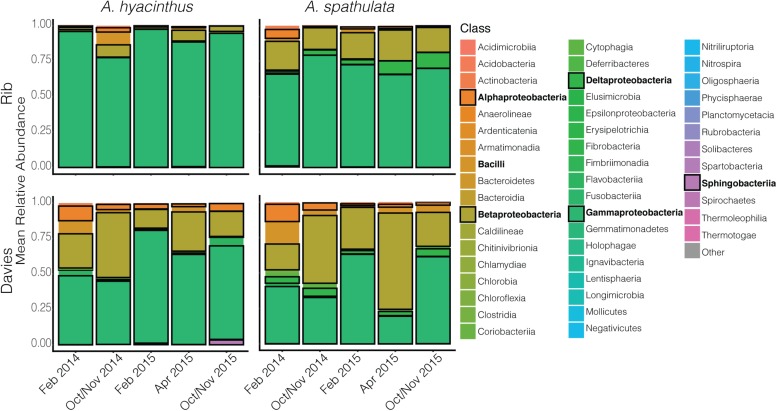
Mean relative abundance of bacterial classes through time for both A. hyacinthus and A. spathulata at Rib and Davies reef. Classes in bold represent those that are in highest relative abundance.